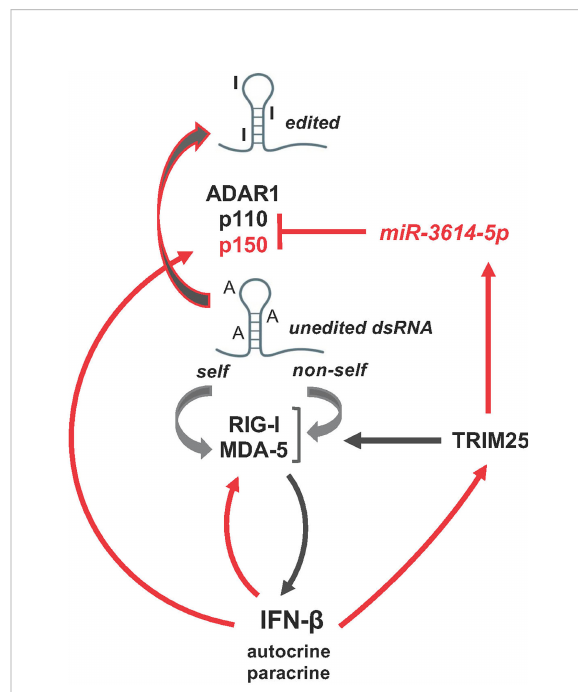
FIGURE 7 Schematic representation of miR-3614-5p involvement in the network of activation of the dsRNA sensors RIG-I and MDA-5 mediating induction of IFN-I and in fl ammatory response. Of these intricate pathways only the few actors studied here are depicted. Red arrows, transcriptional gene induction by IFN-I, which acts in an autocrine and paracrine